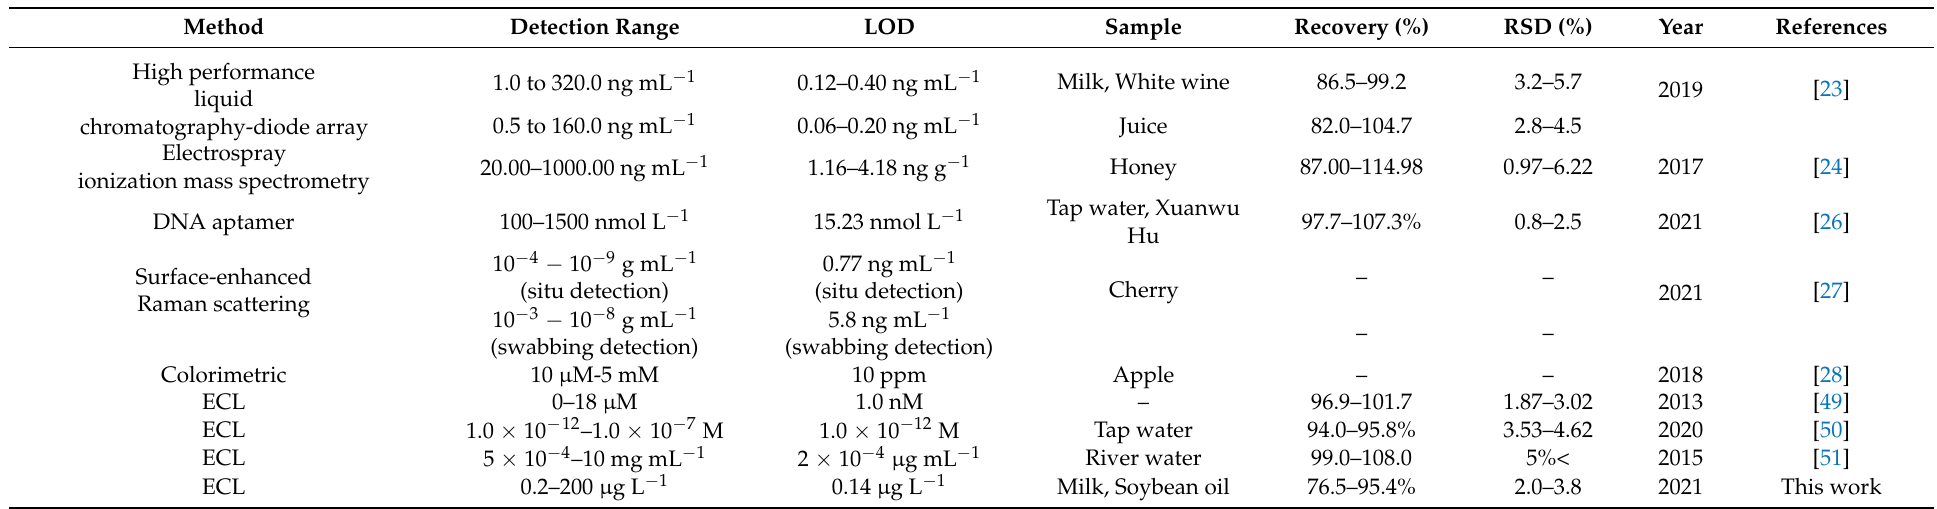
Table 2. Comparison of the proposed method with other reported methods in the